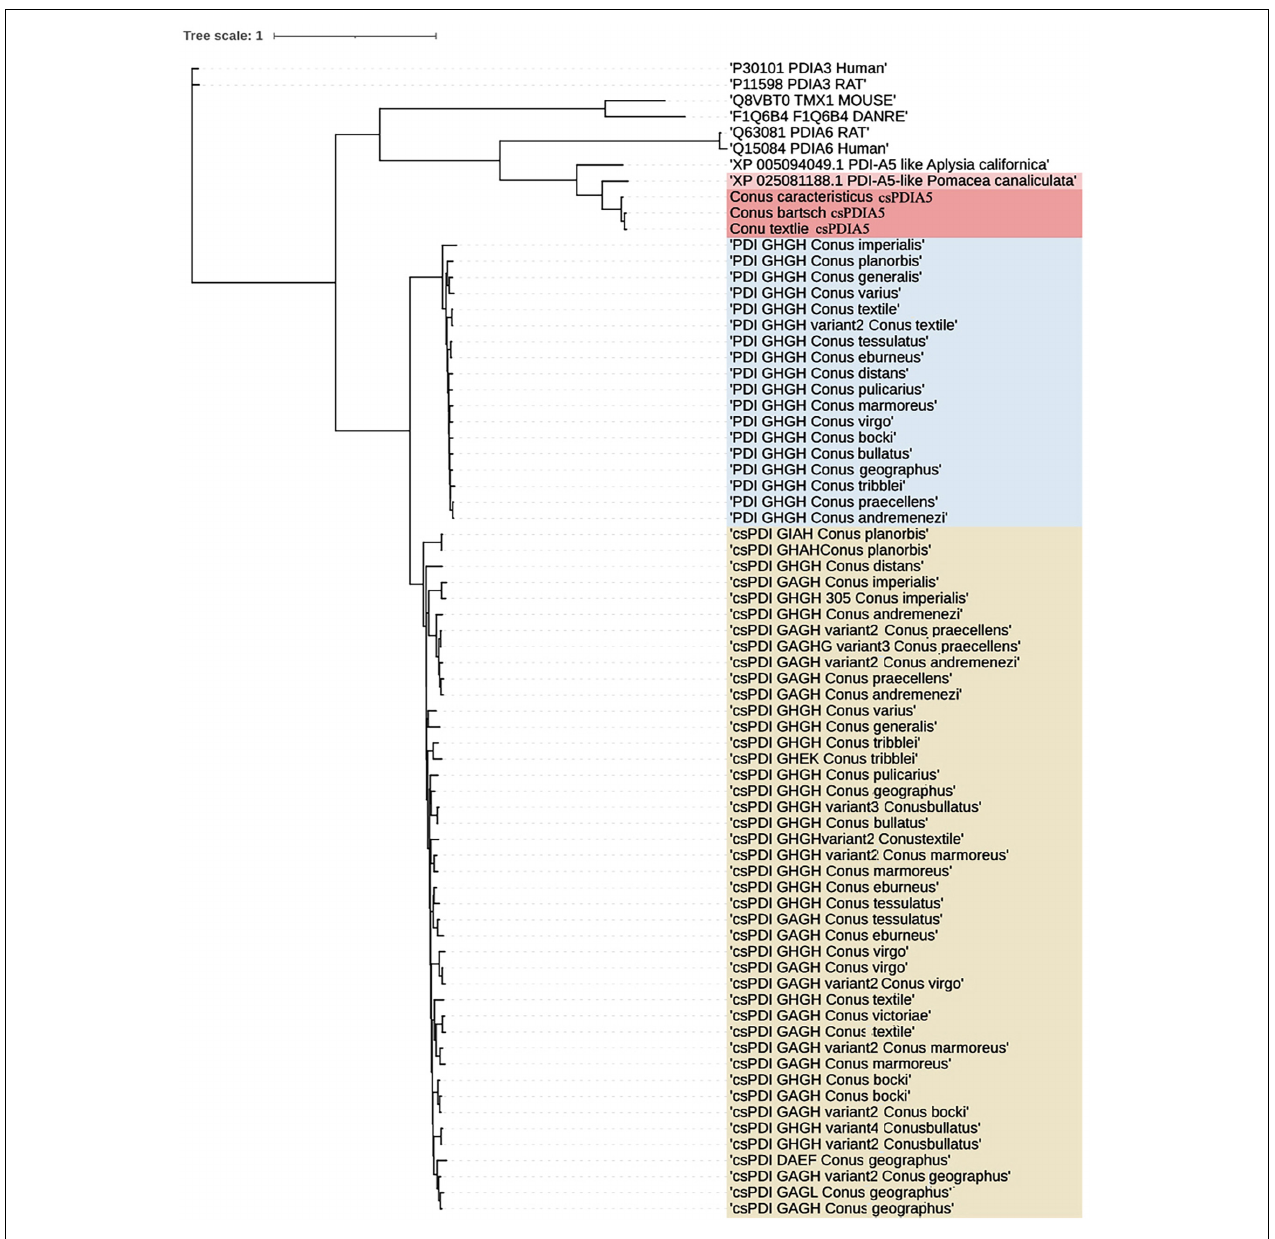
FIGURE 6 | Phylogenetic analysis of members of the PDI gene family. Trees were reconstructed using the neighbor-joining algorithm in